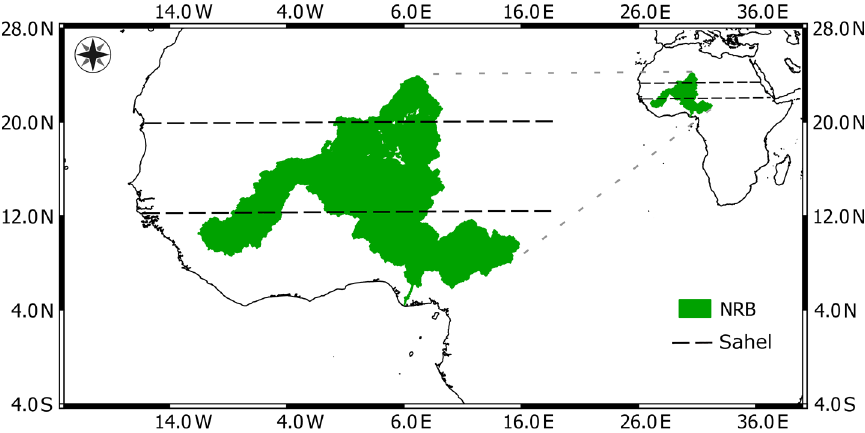
Figure 1. Geographical location of the Niger River Basin (green area) in West Africa.